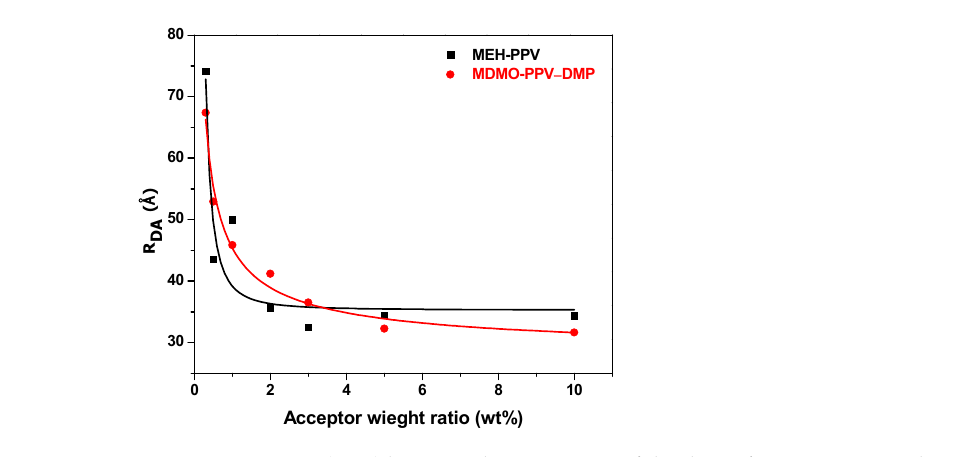
Figure 11. Distance (R DA ) between the monomers of the donor/acceptor versus the acceptor content. Solid curves refer to the fitting data.